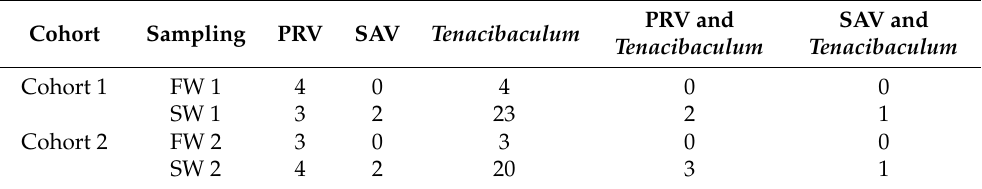
Table 2. Numbers of fish with PCR detected pathogens in the multigene expression assays. Cohort, site, and sampling time-point are indicated.